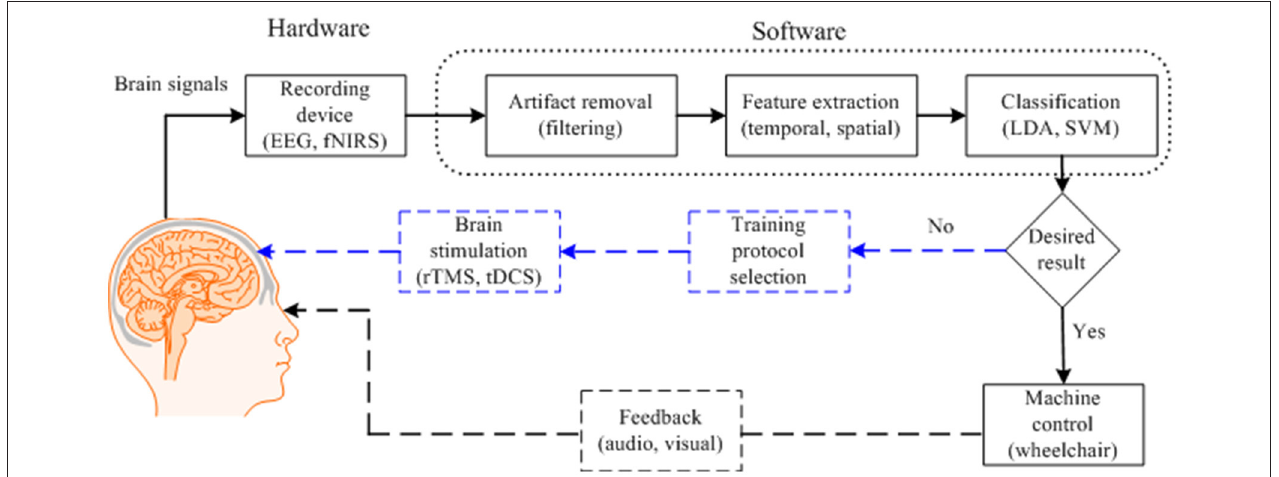
FIGURE 1 | Typical brain-computer interface scheme for control applications with brain function recovery.